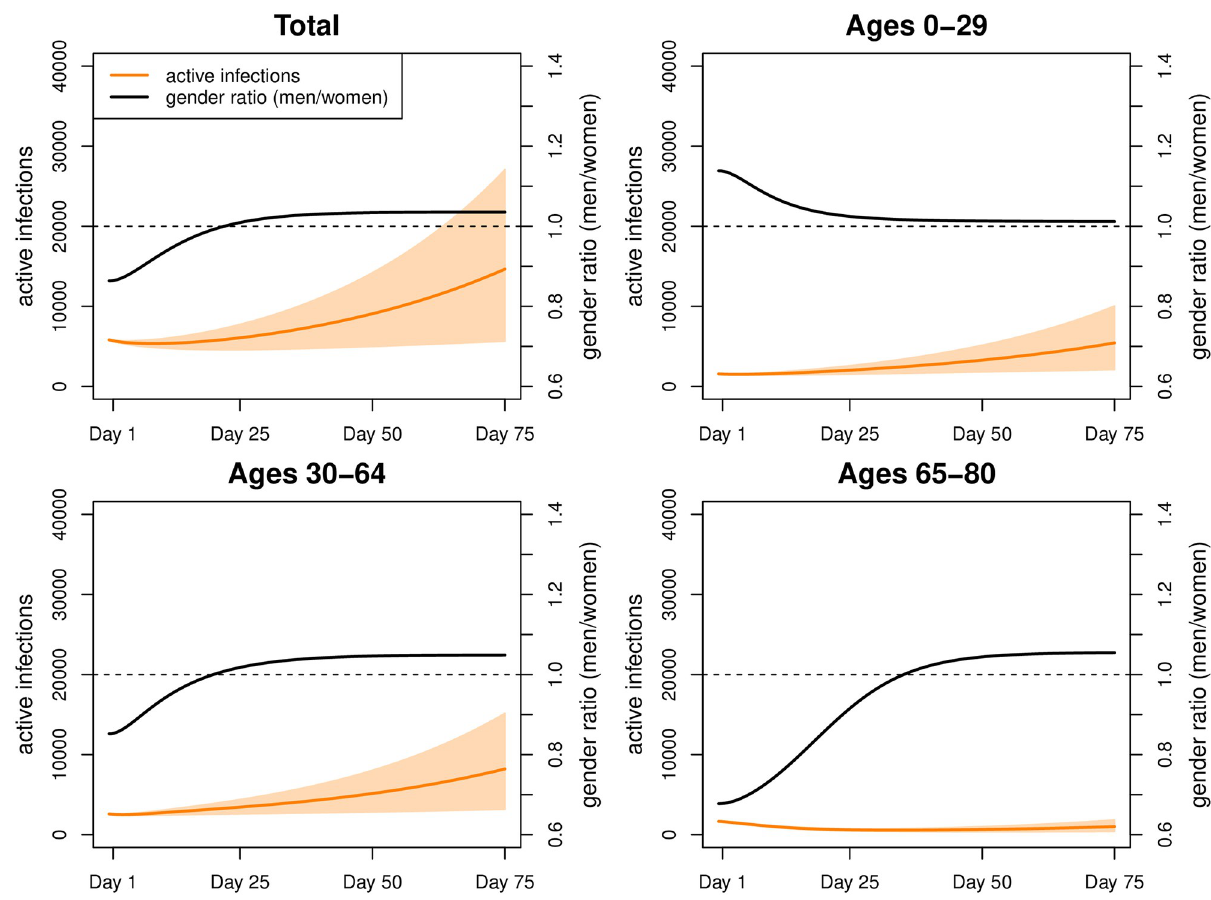
Fig 9. Simulation results for Scenario 4. Number of active infections and gender ratio (men/women) in Scenario 4 (intervals represent 80% range due to parameter uncertainty).